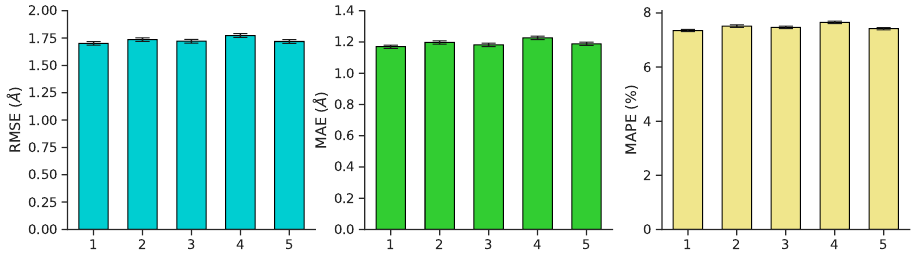
Figure 7. Mean validation performance ± standard error on RMSE, MAE, and MAPE for each of five cross-validation splits. Performance is robust to choice of